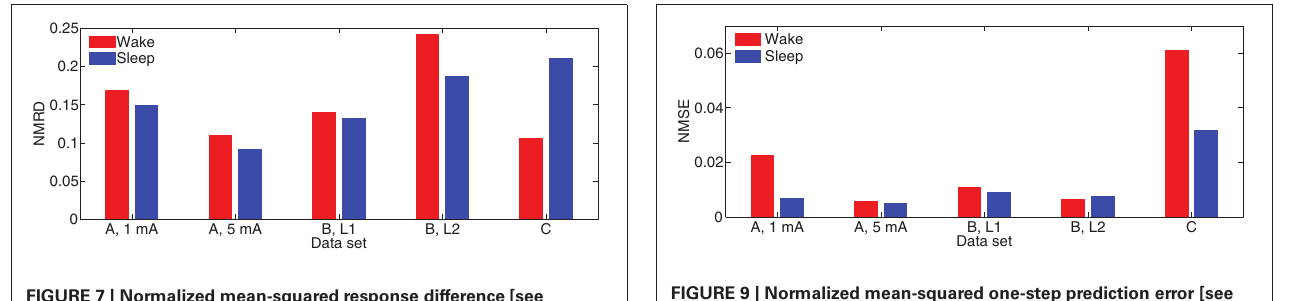
FIGURE 7 | Normalized mean-squared response difference [see Equation (24)] in each dataset.